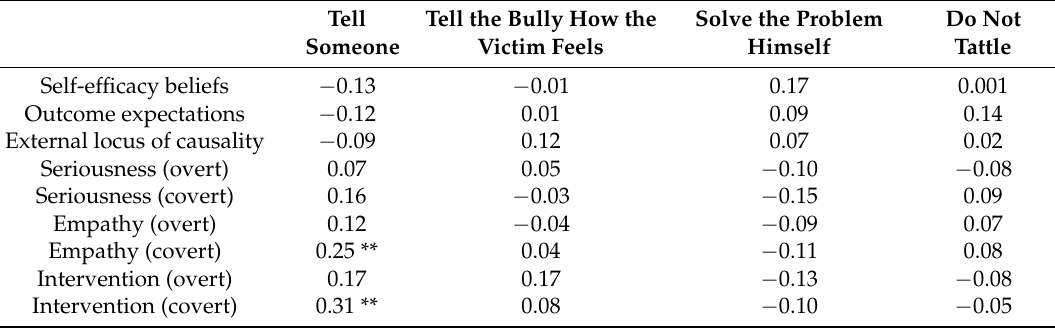
Table 5. Correlations among variables in Italian PST (N =